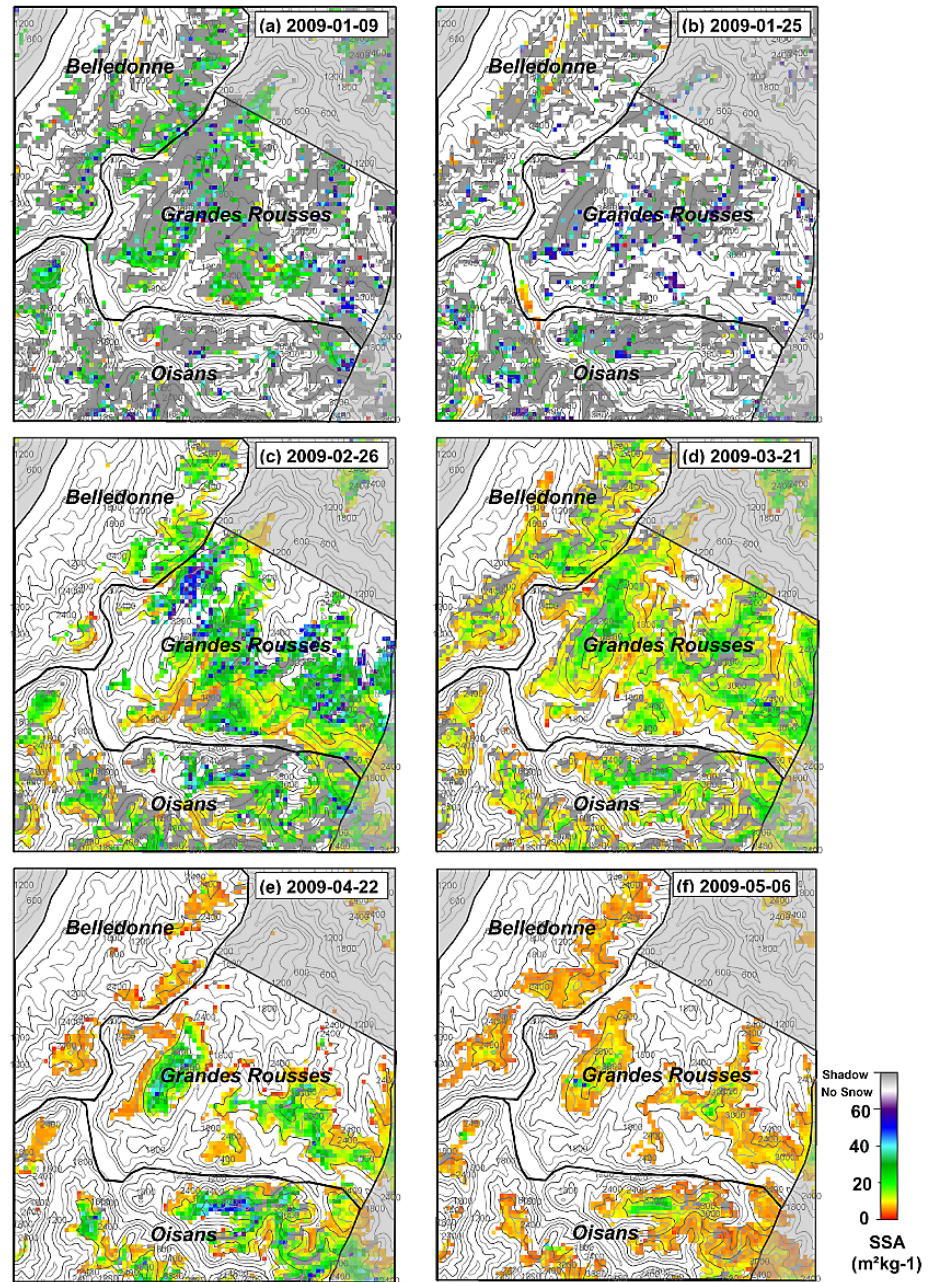
Fig. 5. SSA maps obtained from DTA. Elevation lines are 1000m spaced. Grey pixels are shaded areas. White pixels are not detected as snow. Delimitation of the SAFRAN massifs Belledonne, Grandes-Rousses and Oisans are also